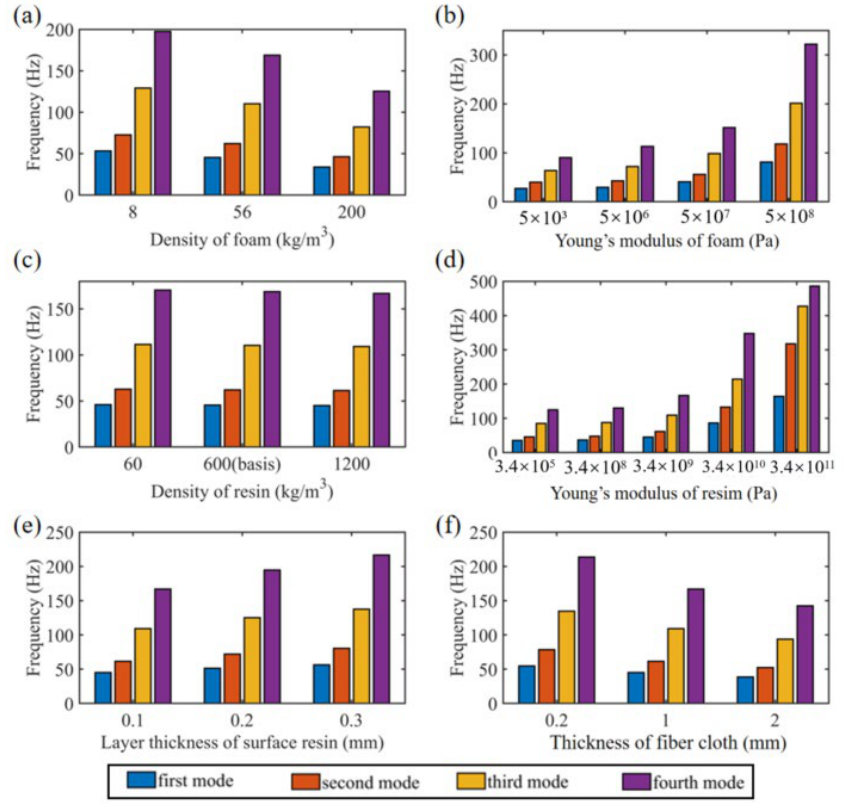
Figure 7. Parametric studies on the effects of the related design parameters on the vibration properties of the CFCPs. ( a ) The effect of foam density. ( b ) The effect of foam’s Young’s modulus. ( c ) The effect of resin density. ( d ) The effect of resin’s Young’s modulus. ( e ) The effect of layer thickness of surface resin. ( f ) The effect of the fiber cloth thickness.